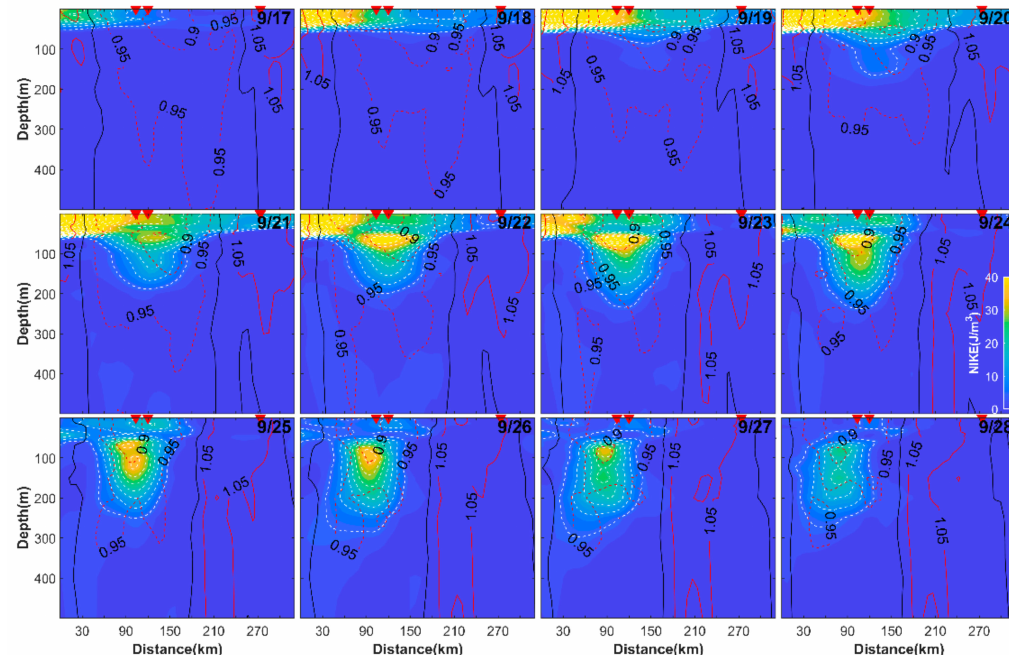
Figure 12. Evolution of NIKE (color and white dashed contours) and effective Coriolis frequency (black contours, red solid contours and red dashed contours) along the section in the central subfigure of Figure 10 based on the HYCOM dataset. The uppermost red inverted triangles denote the locations of M3, M1, and M2 from left to right, respectively. The white dashed contours denote NIKE and start at 5 J/m 3 with a stride of 5 J/m 3 . The red dashed, black solid and red solid contours denote effective Coriolis frequencies that lower than unity, equal to unity and higher than unity,